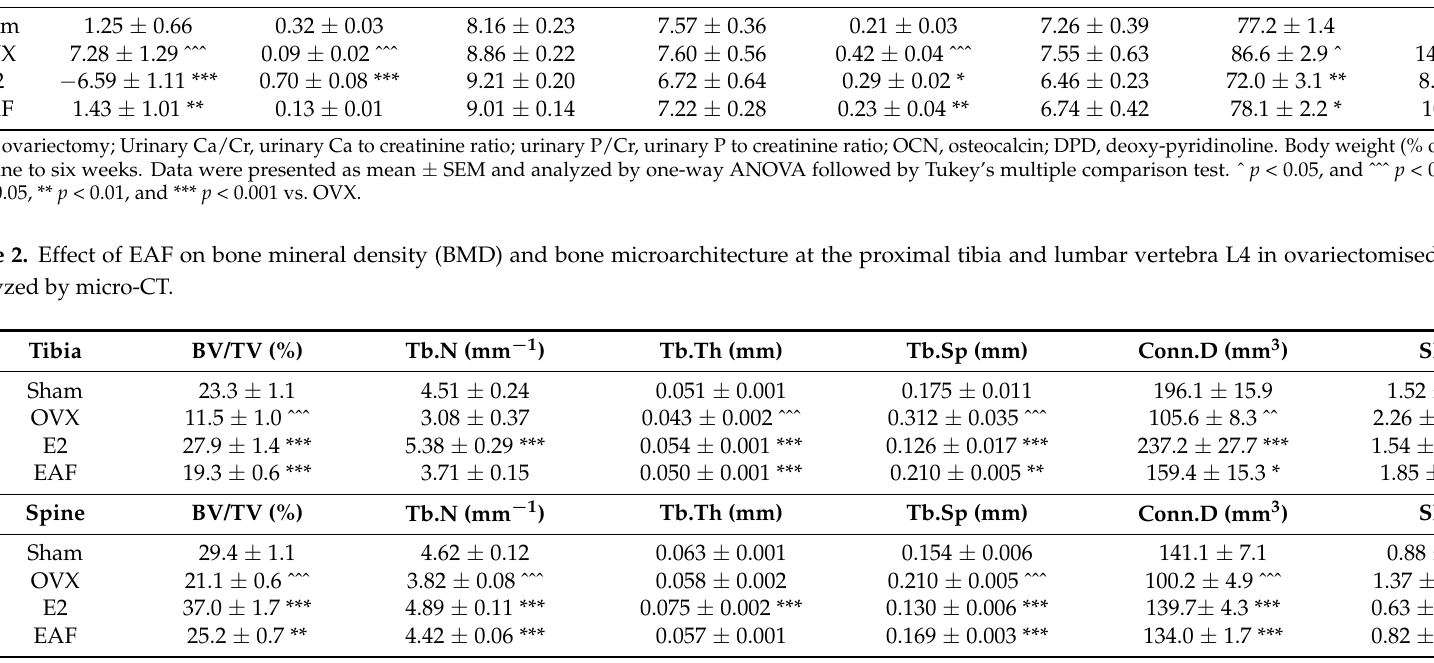
Table 1. Effects of ( − )- epi afzelechin (EAF) on body weight, uterine index, and biochemical parameters in ovariectomised C57BL/6J mice. Body Weight